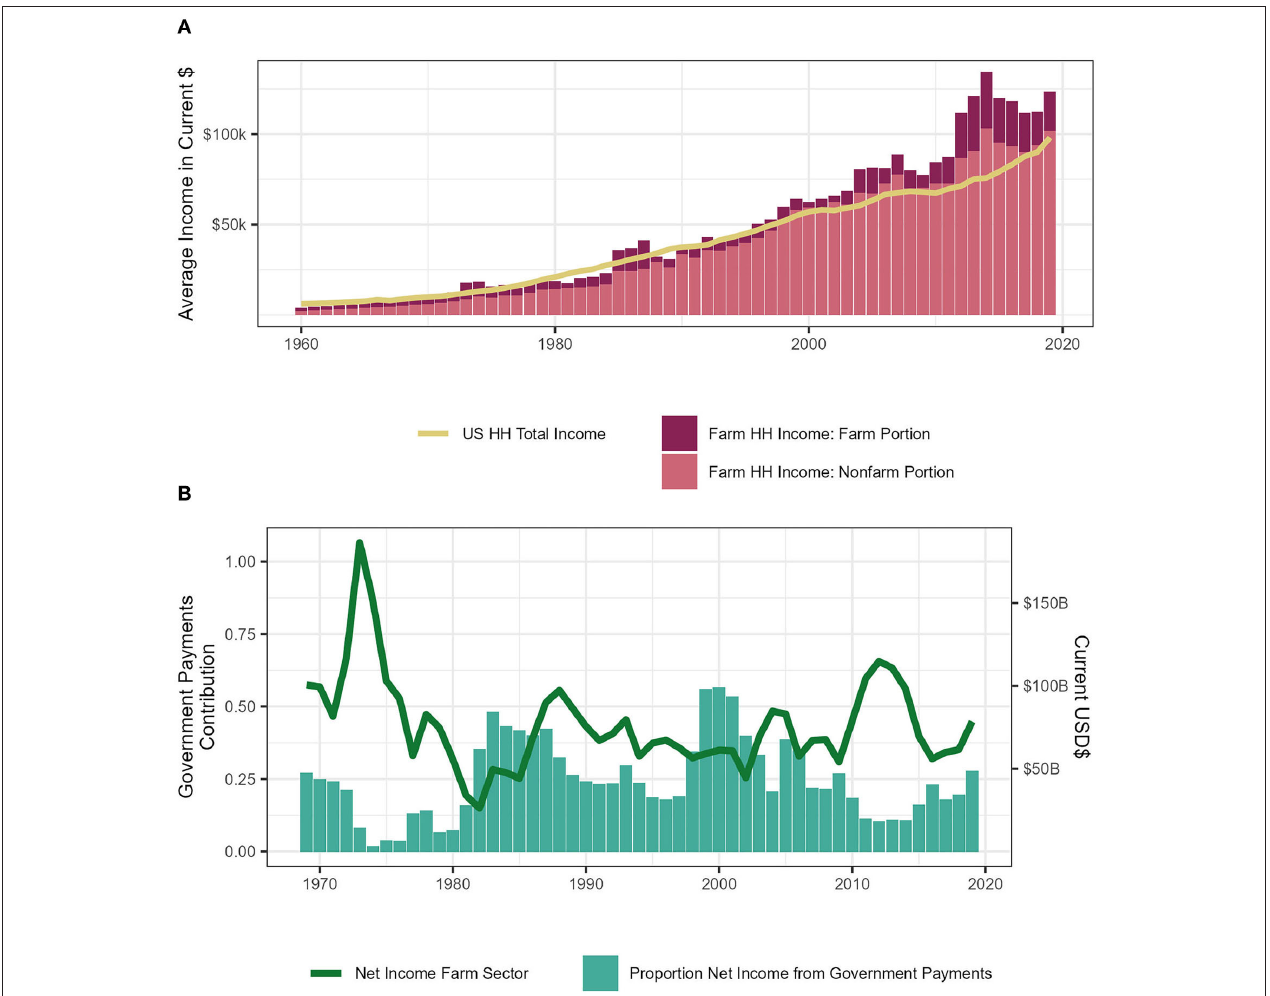
FIGURE 5 | (A) Average farm household income and US household income in current $. Data: USDA ERS, 2020. (B) Contribution of government payments to net farm sector income, in current $. Data: US BEAd.